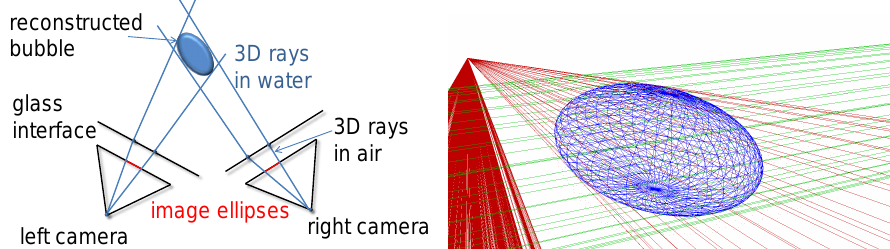
Figure 10. Left : ellipsoids are computed by determining the boundary rays corresponding to the contours in the images. Right : when viewed in 3D, so-called boundary cones are defined when discretely sampling the points on the contours in the images. The red cone is from the first camera and the green cone from the second camera. The blue ellipsoid is fitted to lie inside the cone intersection. Note that the computation of 3D rays does not require the projection of 3D points into the images, which is infeasible when using the refractive camera